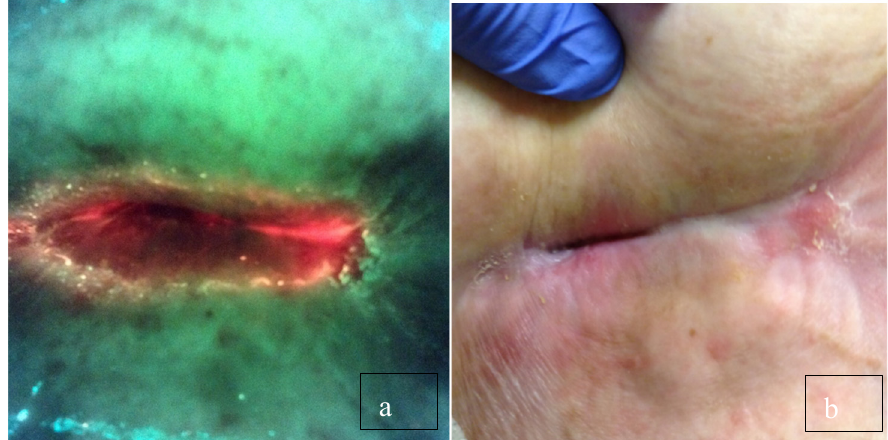
Figure 1. ( a ) Long-standing sacral pressure ulcer negative for bacteria on clinical signs and symptoms. The physician planned to debride the wound and cover it with a plain foam dressing. ( b ) After viewing, the red fluorescence changed the plan to cleansing with hypochlorous acid and applying a topical antimicrobial. Biopsy confirmed >10 5 CFU/g.